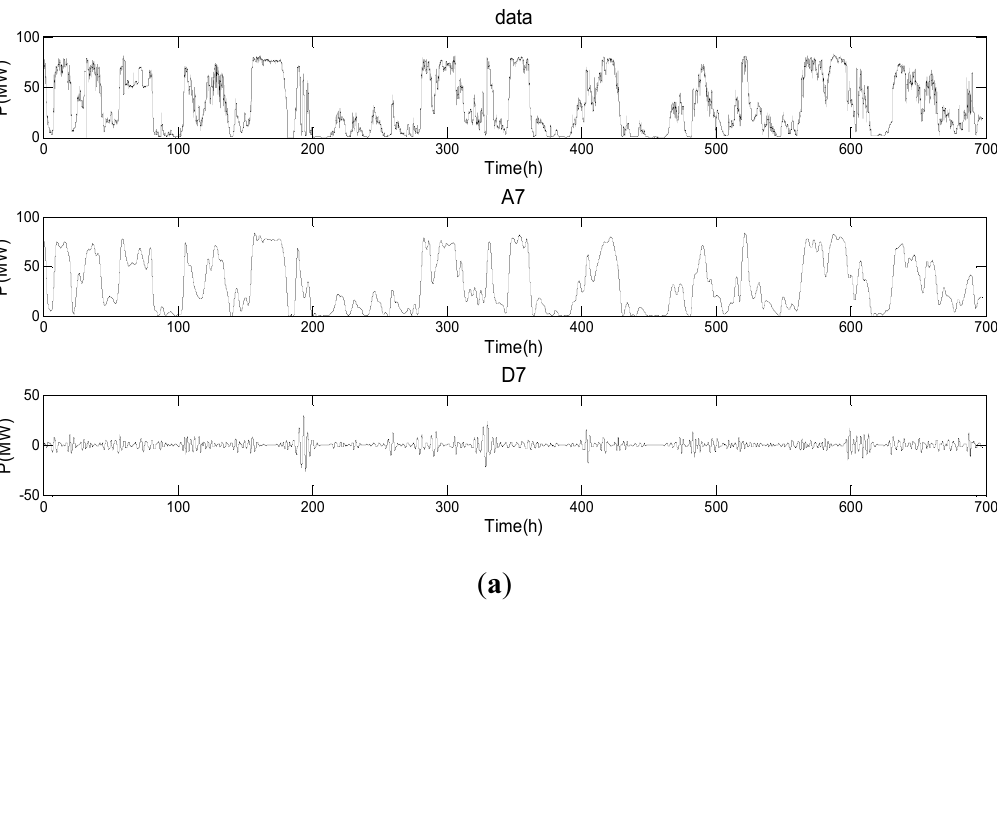
Figure 10. The power curves of wavelet multi-scale decomposition. ( a ) The power curves of low frequency A7 and high frequency D7; ( b ) the power curves from high frequency D4 to D6; ( c ) the power curve from high frequency D1 to